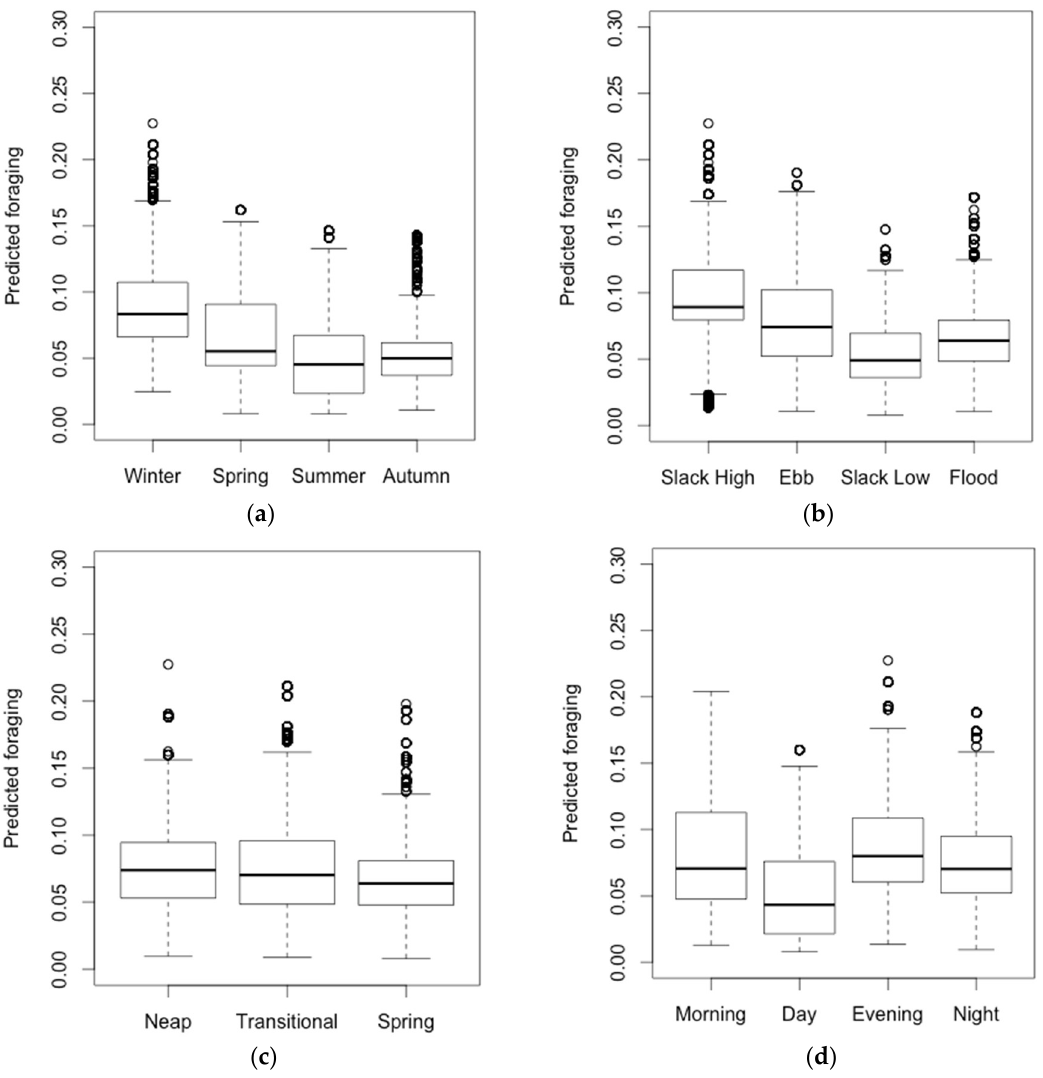
Figure 5. Predicted foraging at Moneypoint for the explanatory variables included in the best model: ( a ) Season; ( b ) Tidal Cycle; ( c ) Tidal Phase and ( d ) Diel Phase.